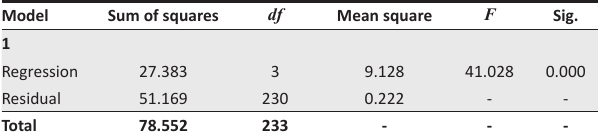
TABLE 4: Analysis of variance table for the multiple regression analysis.